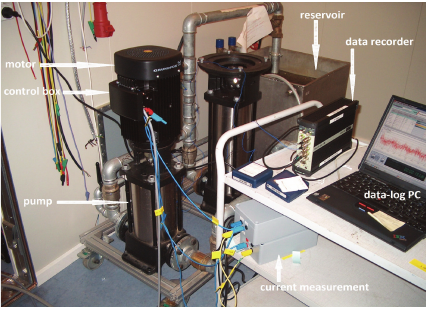
Figure 4: The induction motor placed in a water circulation